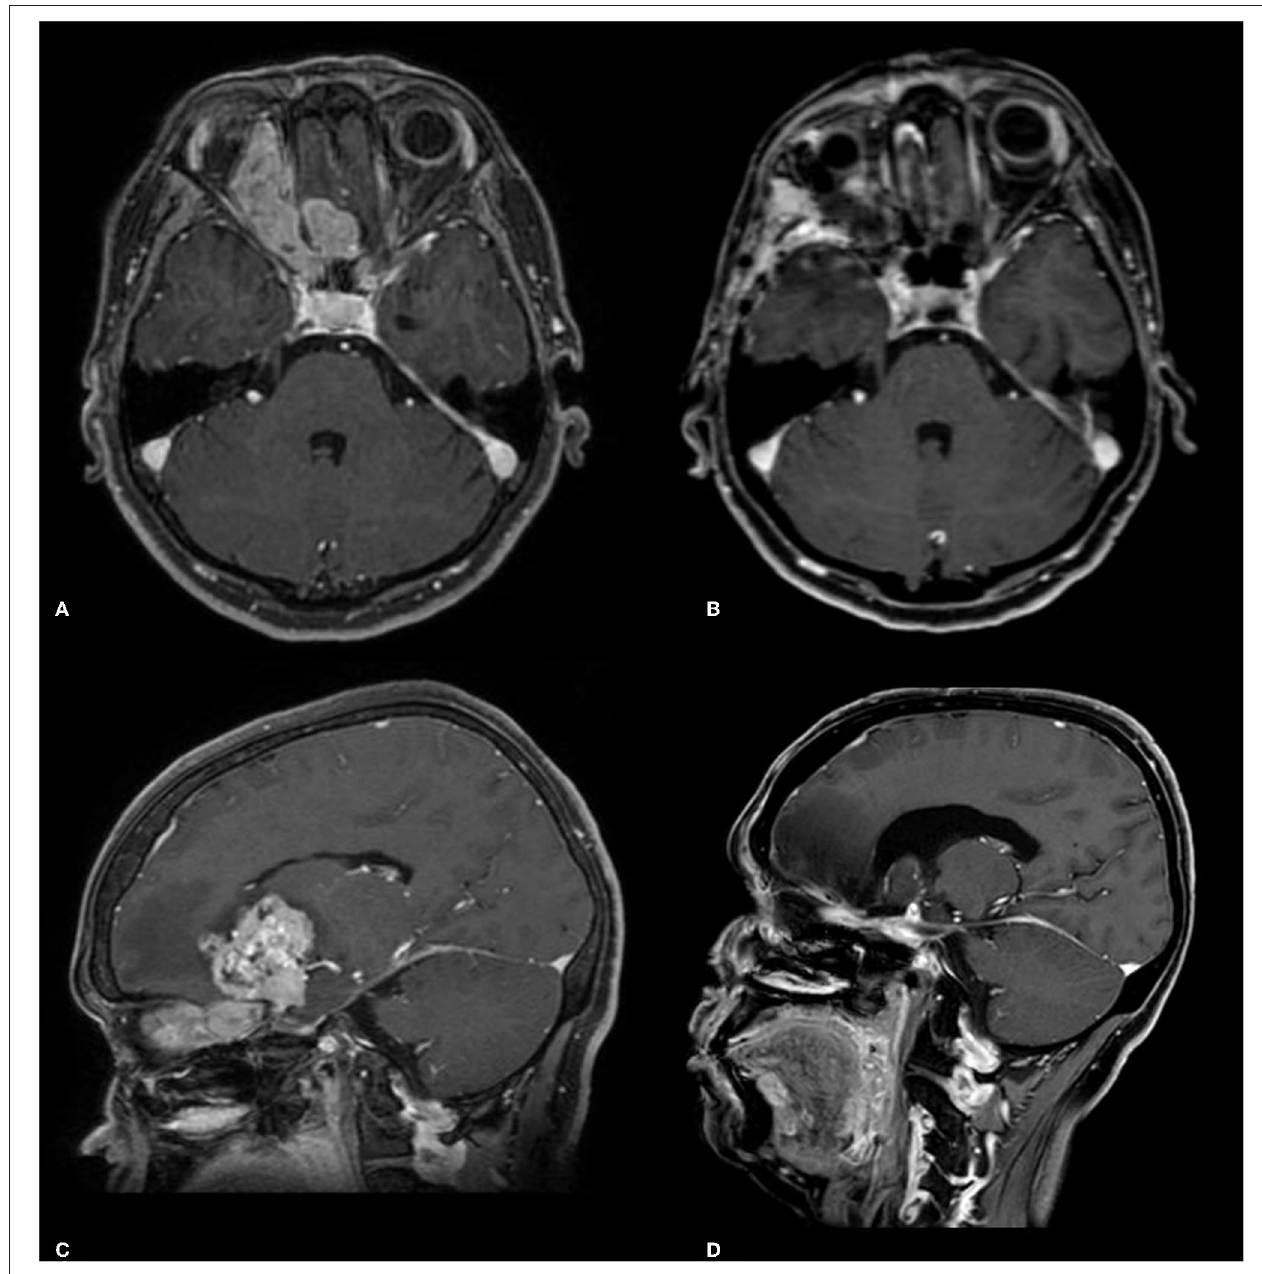
FIGURE 1 | Preoperative post-contrast T1-weighted MRI (A,C) and postoperative images (B,D) .